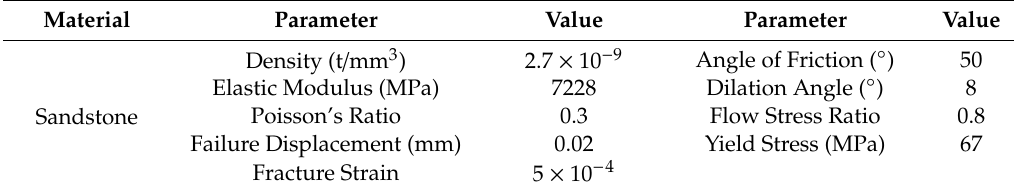
Figure 2. Stress–strain curves of sandstone obtained from experiment and numerical simulation. Table 1. Property parameters of sandstone in the simulation.